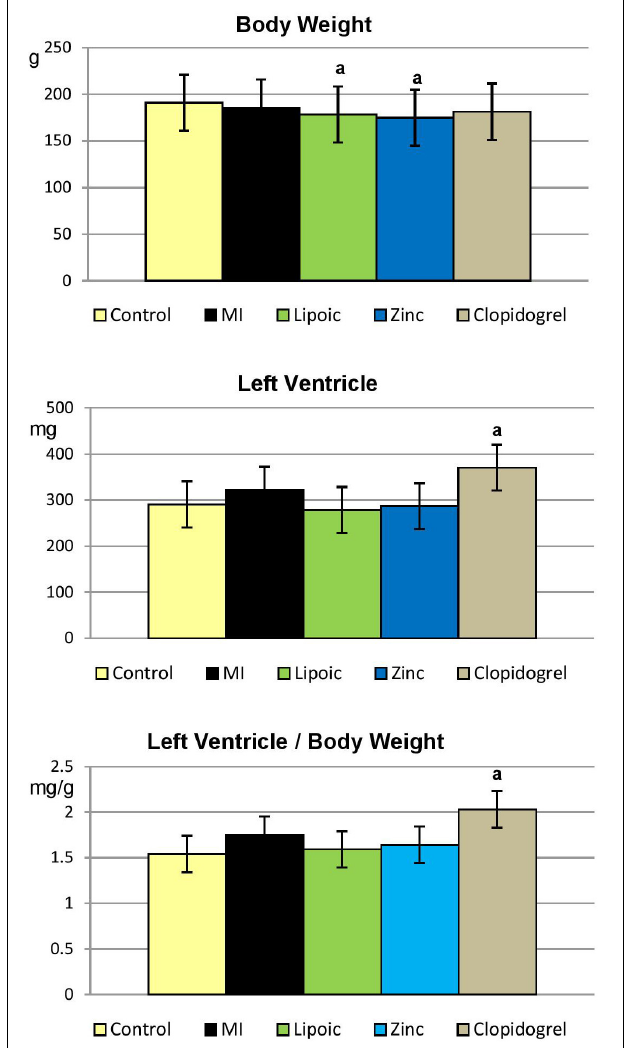
FIGURE 5 | Absolute left ventricular weight and its ratio to body weight in the control, untreated myocardial infarction (MI) and pre-treated (lipoic acid, zinc sulfate, and clopidogrel) groups. Results are represented as mean ± SEM, significance of differences is calculated by Student’s t -test for unpaired data at p < 0.05; a—vs.